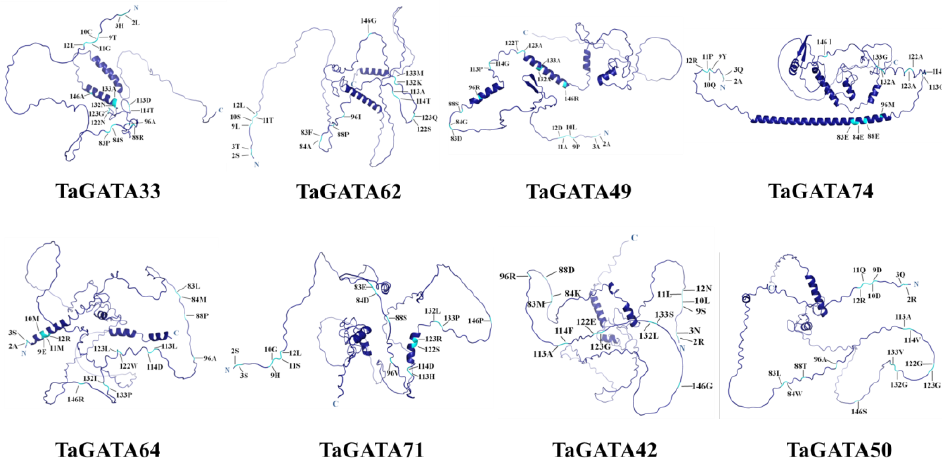
Figure 4. Three-dimensional structures of eight TaGATA proteins from different subfamilies predicted with AlphaFold2 and the distribution of coevolution sites. Table 3. Coevolutionary sites of the TaGATA family *.